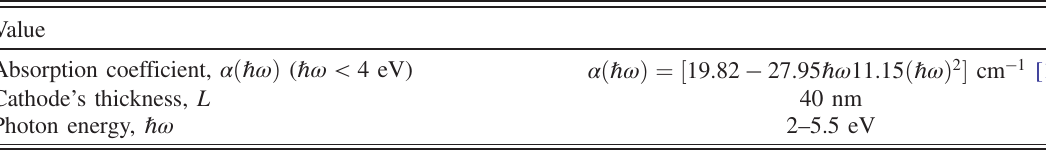
TABLE I. Parameters used to calculate QE from Eq.